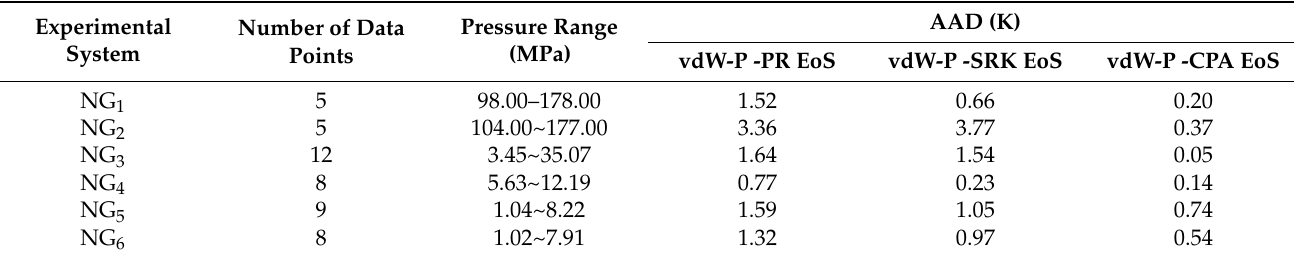
Table 5. Deviation analysis from different models for the hydrate formation temperature in systems NG 1 ~NG 6